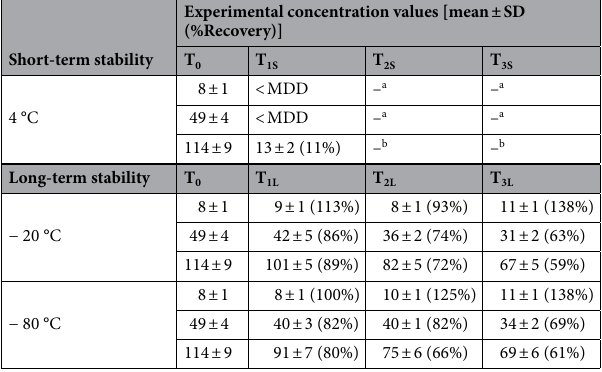
Table 1. Results on stability over time of NT-proBNP in different storage conditions , including the mean %recovery. The short-term stability (T S ) study investigated analyte stability at 4 °C for up to 3 weeks (T 0 :